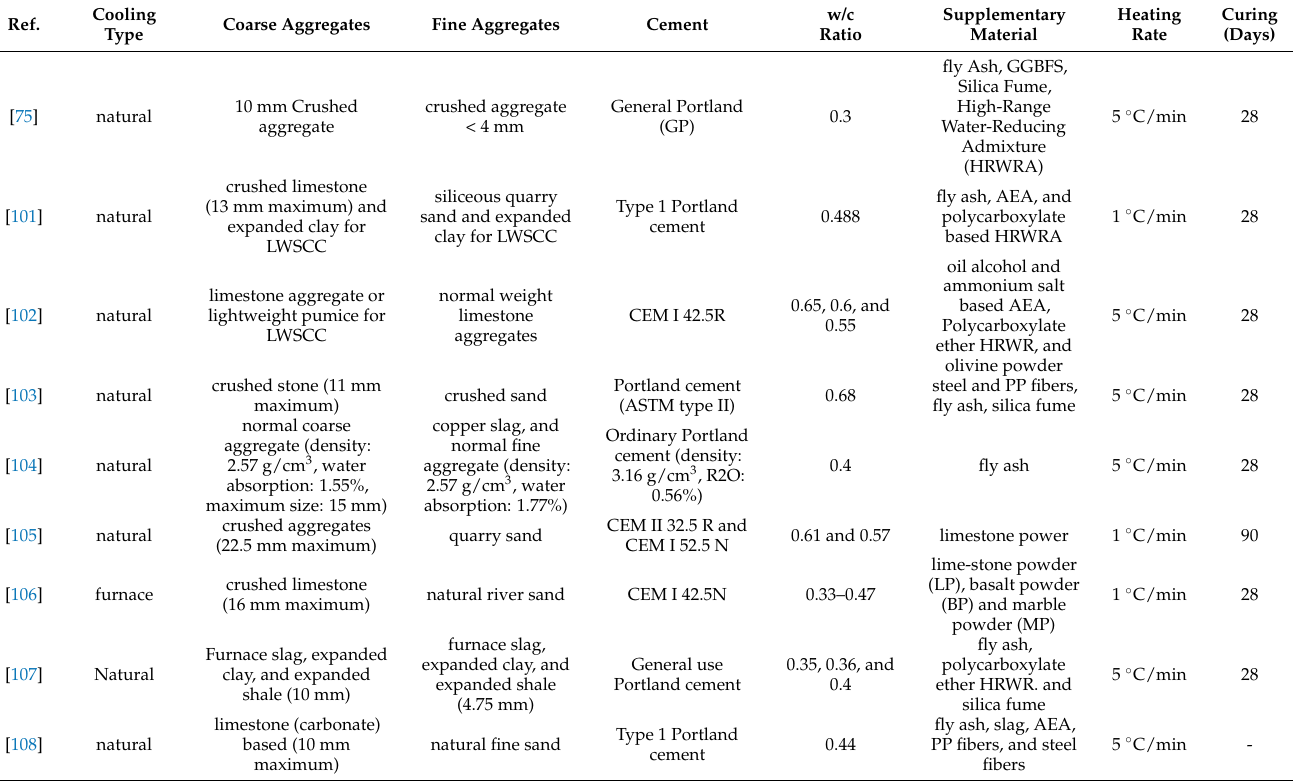
Table 6. Important parameters of different studies on HSC